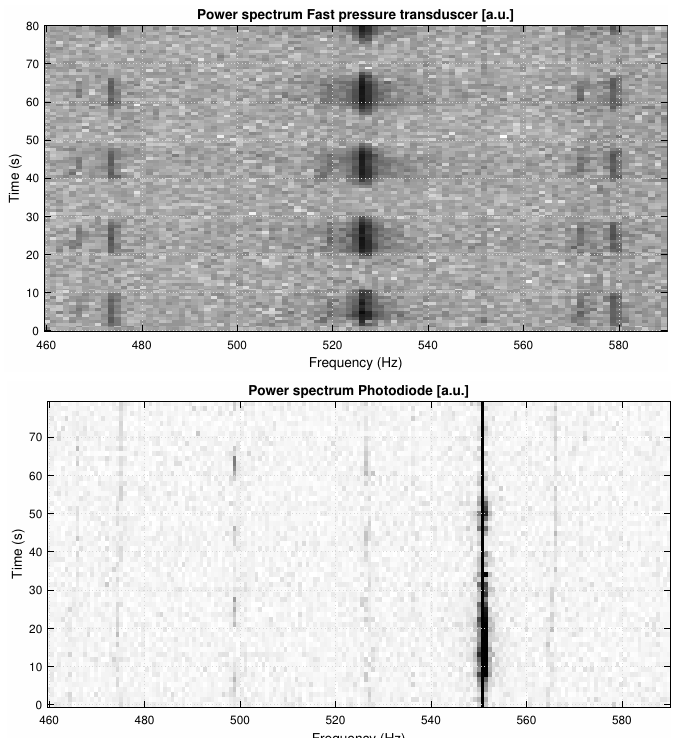
Figure 22. Effective on-off excitation of the confined flame at 525 Hz at 2.3 bar. ( Top ) Readings of the fast pressure sensor. ( Bottom ) Reading of the optical sensor of the RCP probe